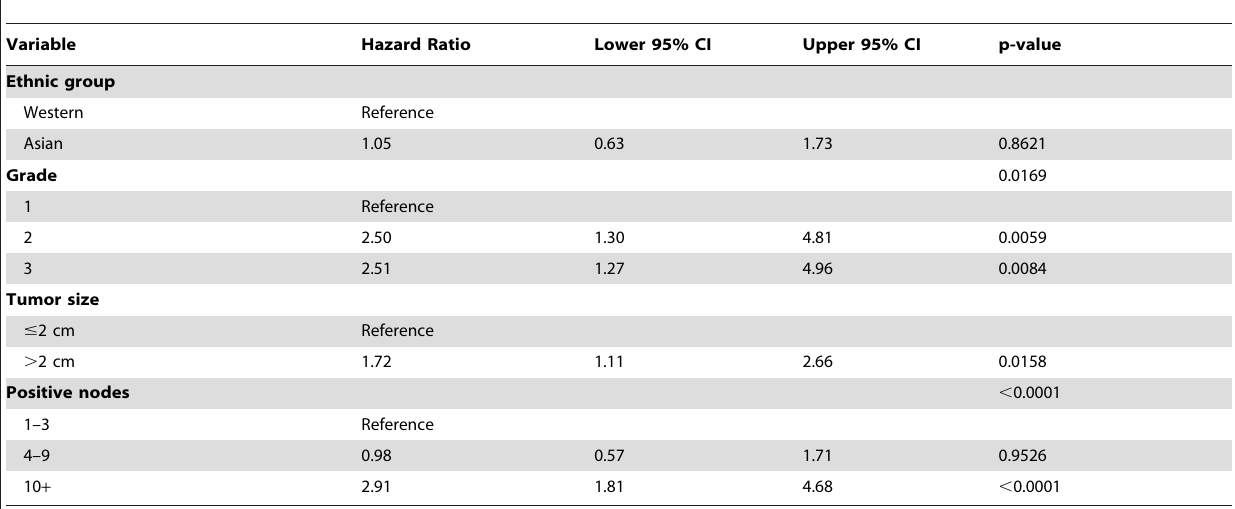
Table 4. Multivariate analysis for disease-free survival in the hormone receptor positive